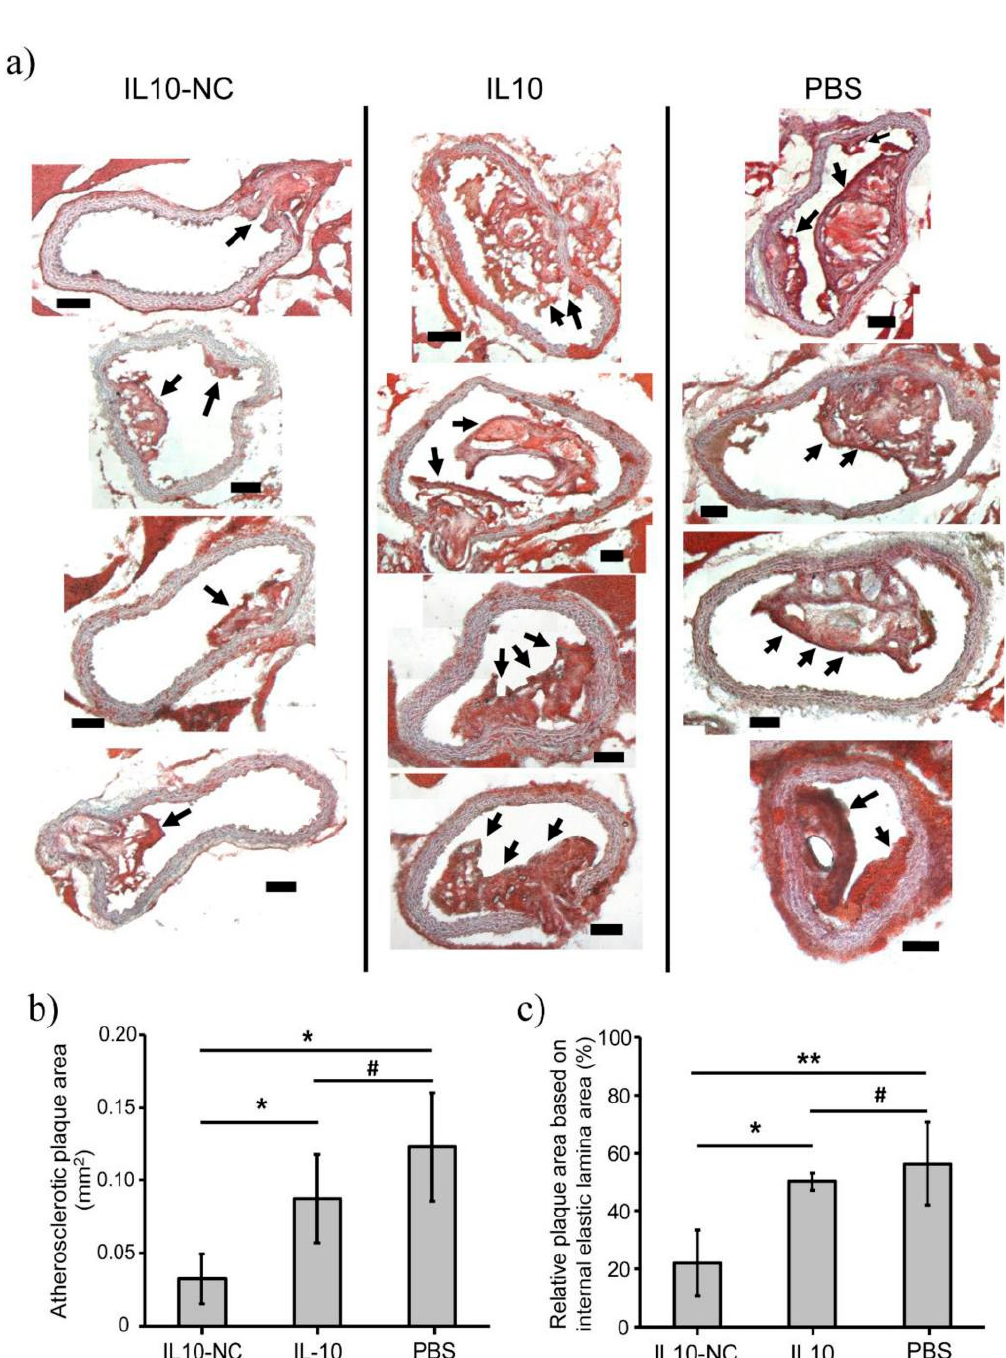
Figure 5. ( a ) Oil red O (ORO) staining of plaques in aortic root cross-sections after i.v. injection of IL-10-NC, IL-10, and PBS. Samples were injected once a week for 3 weeks. Black arrows indicate plaques. Quantitative analysis of relative atherosclerotic plaque area ( b ) from the ORO-stained ( a ) images, and ( c ) based on internal elastic lamina area and atherosclerotic plaque area ( n = 4, * p < 0.05, ** p < 0.01, and # not significant). Reprinted from Biomaterials. Kim, M., et al., Targeted delivery of anti-inflammatory cytokine by nanocarrier reduces atherosclerosis in ApoE –/– mice, pages 119550. Copyright 2020, with permission from Elsevier [60].